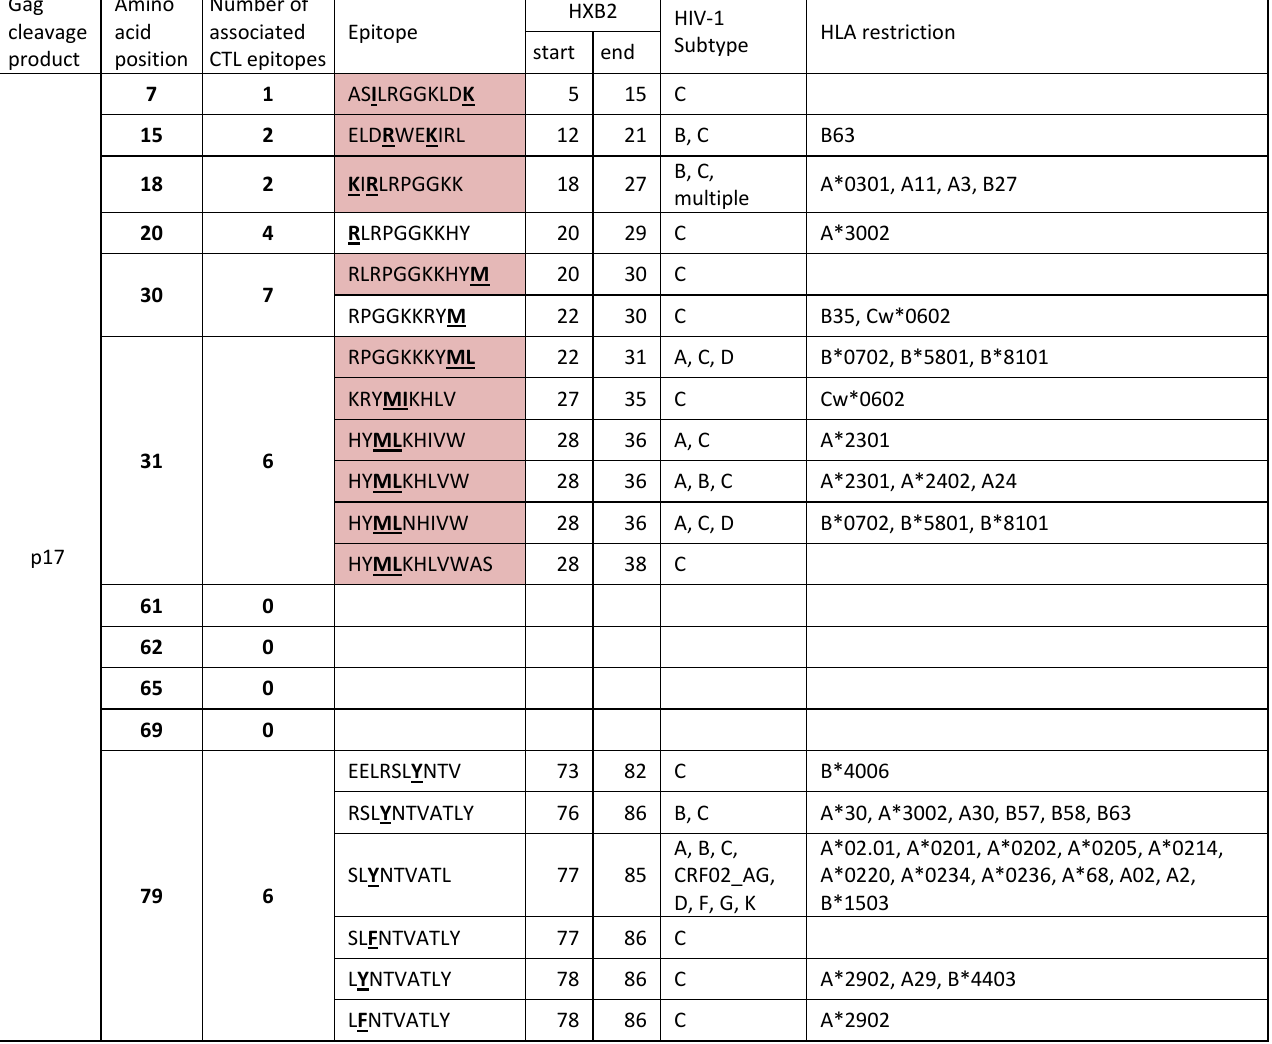
Table 2. Amino acid positions in HIV-1 subtype C Gag with frequency change 10% to 20% in the subtype C consensus sequence: potential association with known CTL epitopes (Note: Epitopes with multiple changing amino acids are highlighted; changing amino acids are shown in bold and